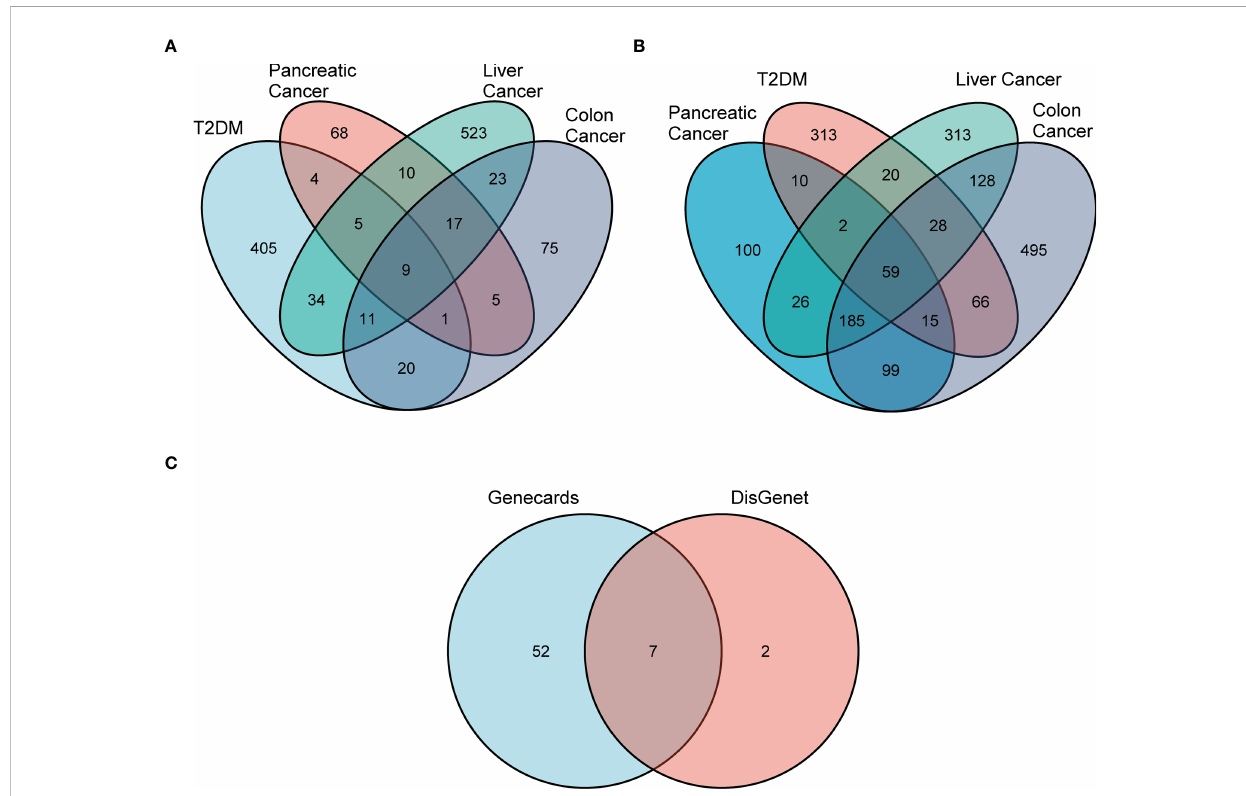
FIGURE 1 Screening for differential DCRGs. (A) Venn diagram showing nine intersection genes of fi ve diseases, T2DM, pancreatic cancer, liver cancer, and colon cancer, based on DisGeNET (r > 0.1). (B) The 59 intersection genes of the fi ve diseases based on GeneCards (r > 0.1). (C) The seven DCRGs obtained by the intersection of DisGeNET and